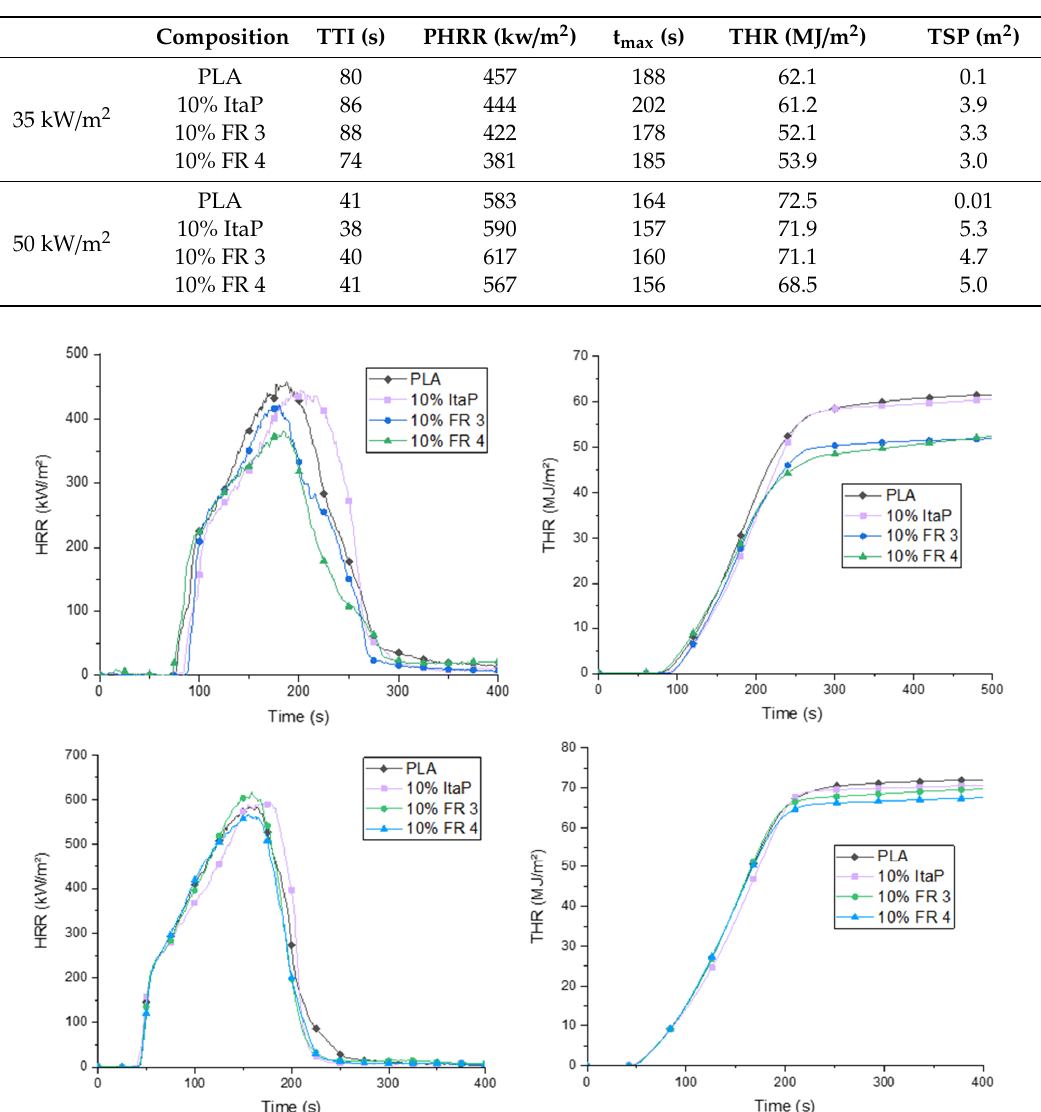
Table 5. Cone Calorimetry results of flame retardant formulations in PLA with a sample thickness of 3 mm.